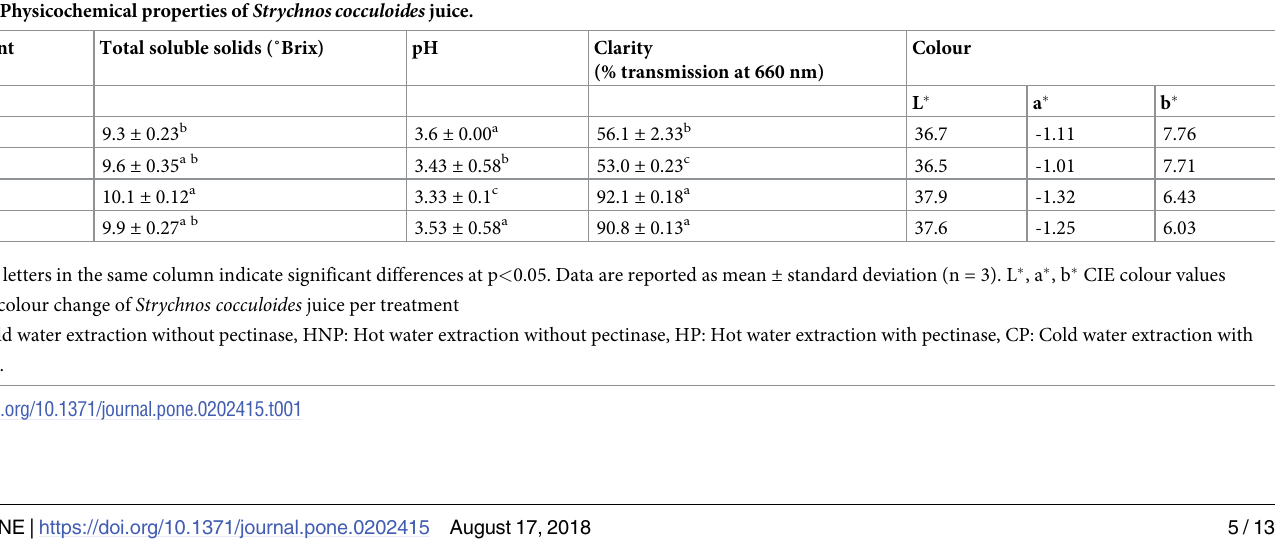
Table 1. Physicochemical properties of Strychnoscocculoides juice. Treatment